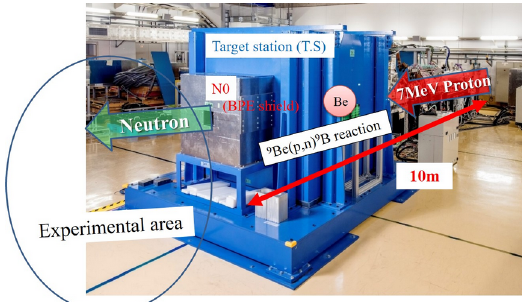
Figure 1 : Picture of RANS and experimental hall